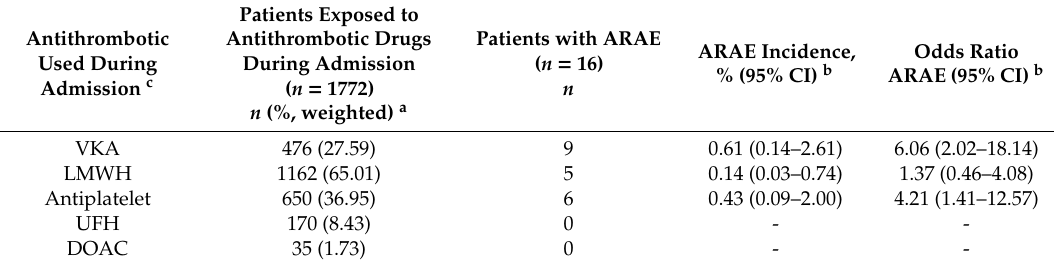
Figure 2. Adjusted standardized MRAE and ARAE incidence in deceased and discharged populations between 2008 and 2015/2016. Table 2. Antithrombotic use and occurrence of antithrombotic related adverse events in the 2015/2016 deceased hospital population.